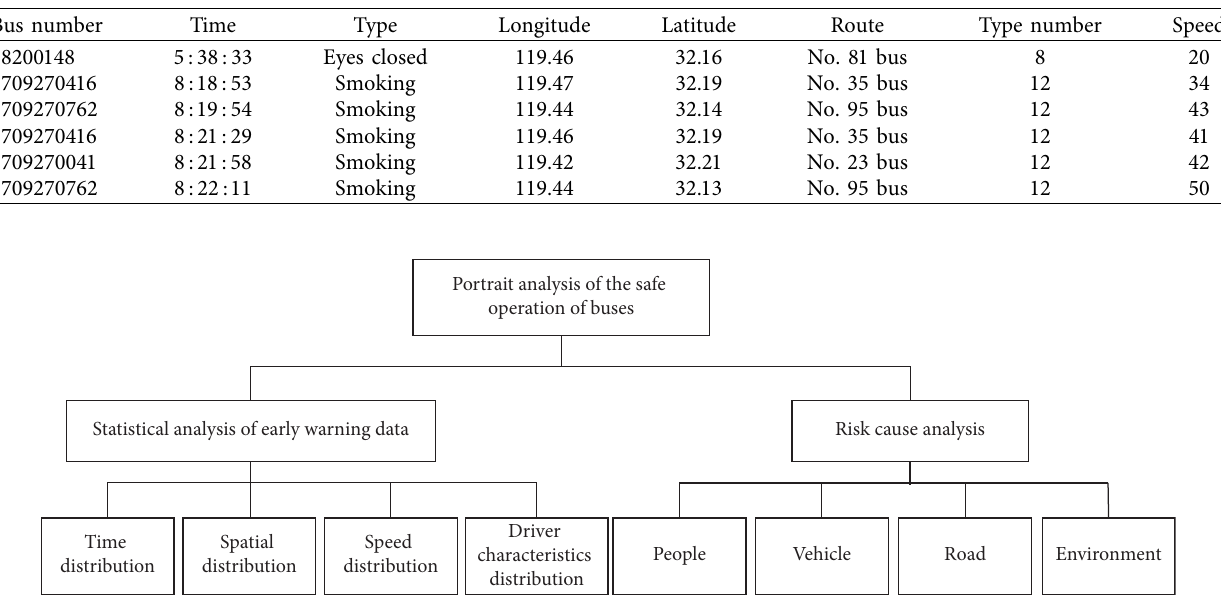
Table 3: Data sample after cleaning.